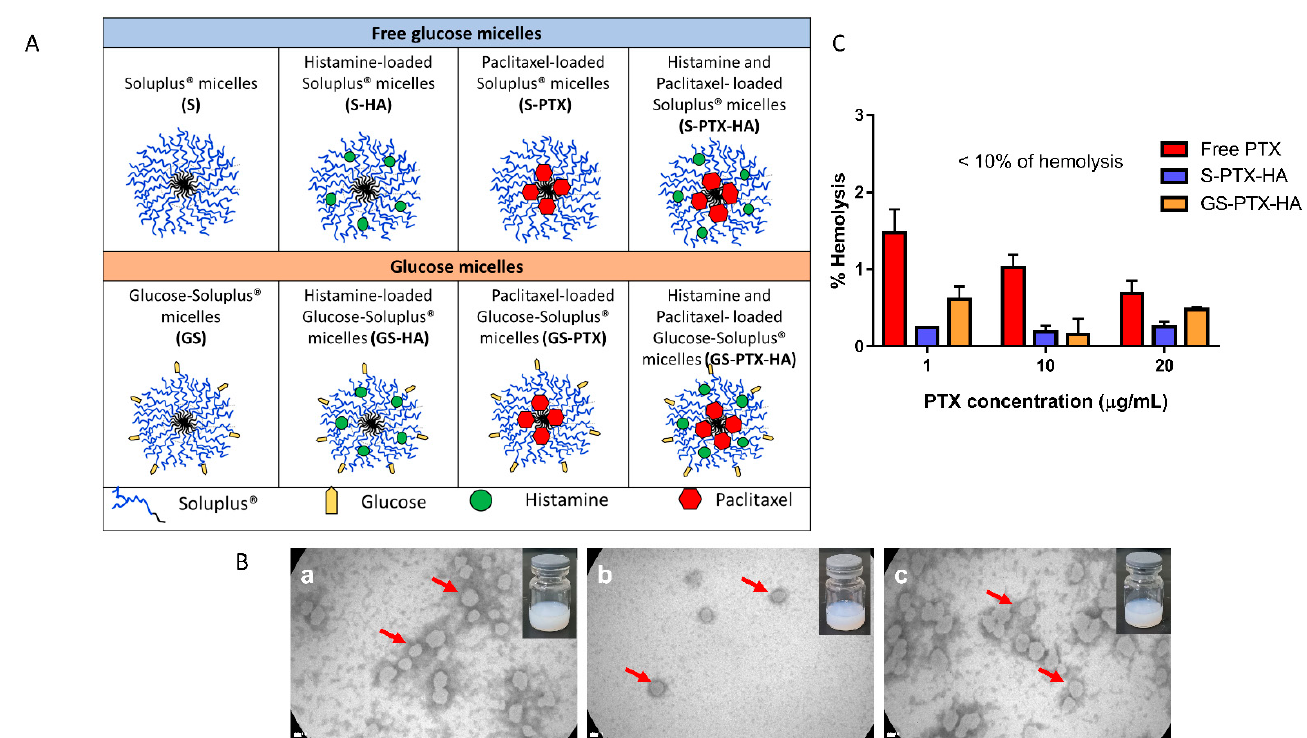
Figure 1. Characterization of nanomicellar polymeric formulations. ( A ) Hypothetical scheme. ( B ) TEM micrograph of ( a ) GS-HA, ( b ) GS-PTX, and ( c ) GS-PTX-HA micelles. Red arrows point out the polymeric micelles. Scale bar: 20 nm. Photo Inset: macroscopic aspect of the three nanoformulations. ( C ) Percentages of hemolysis of free PTX and PTX-HA co-loaded micellar systems after incubation with erythrocyte suspensions for 1 h at 37 °C. Error bars represent the mean ± SD ( n = 3 independent experiments).